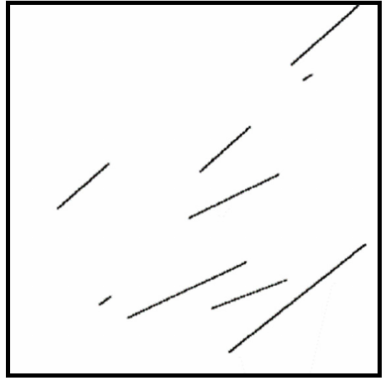
Figure 2. Schematic of fracture model.